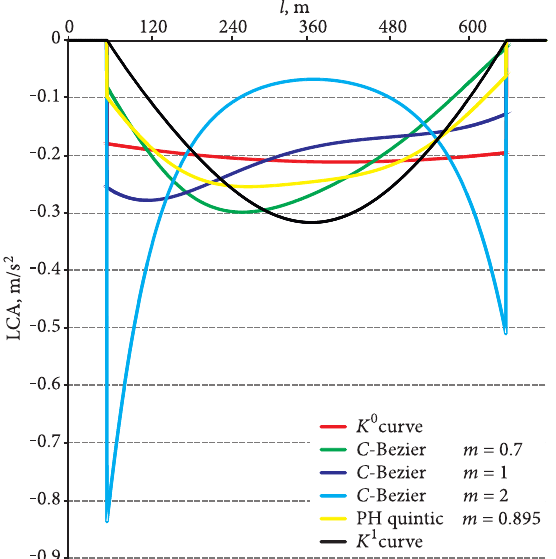
Fig. 13. LCA diagram of the S -shaped curves in motion model with constant